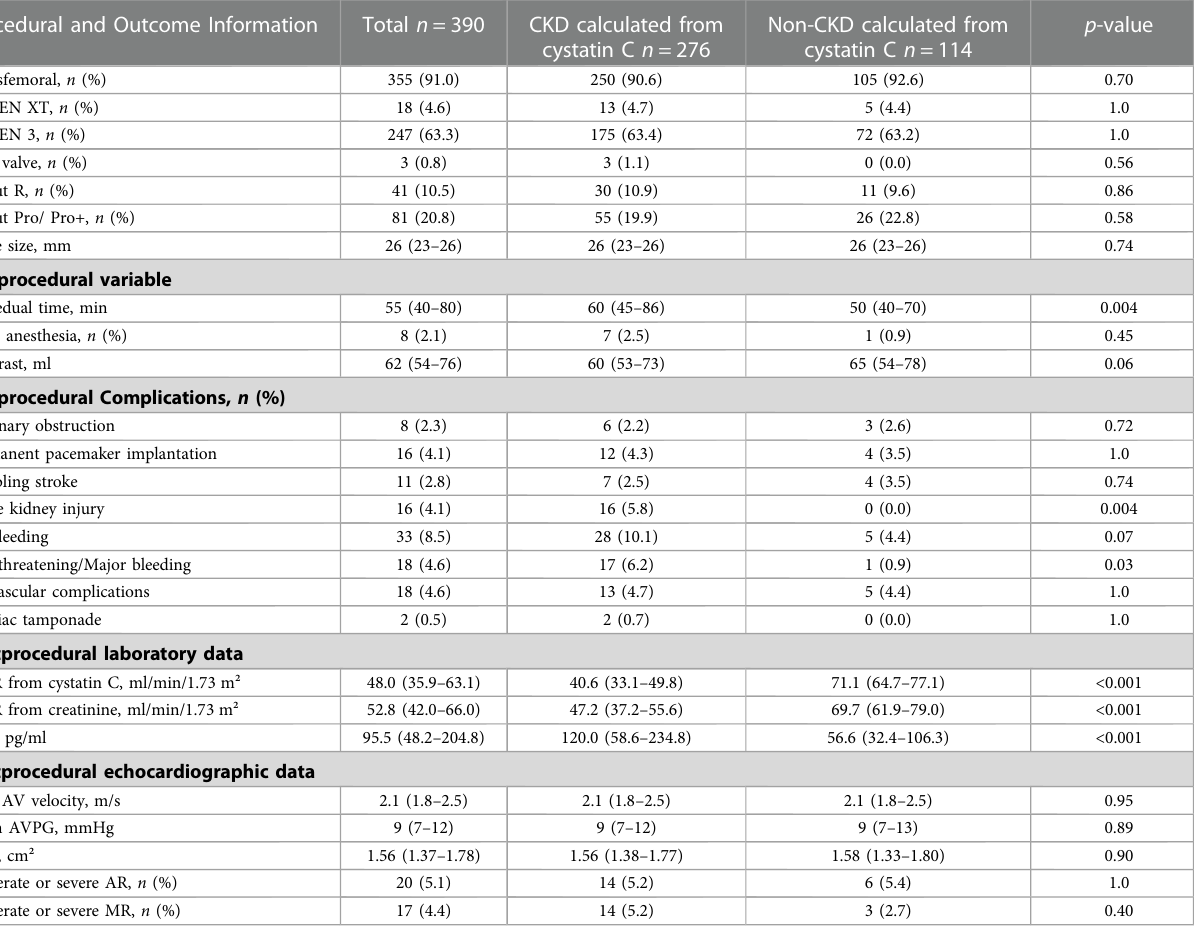
TABLE 2 Peri – and postprocedural outcome